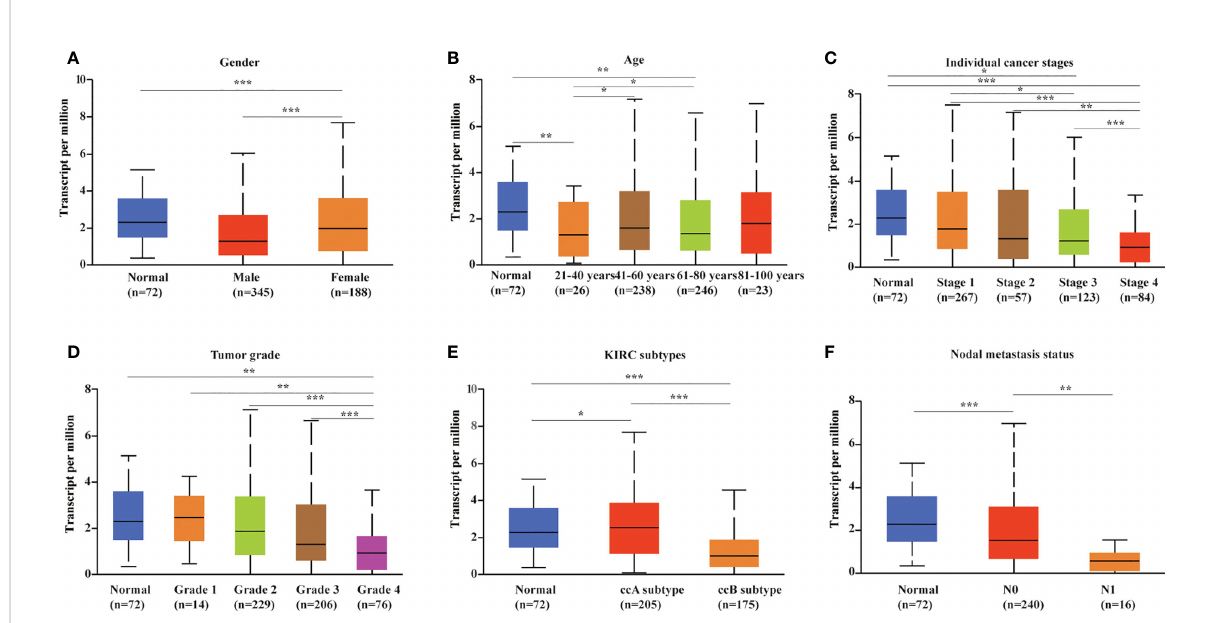
FIGURE 3 METTL24 expression in different patient groups. The box plots showed the relationship between METTL24 expression and parameters including (A) sex, (B) age, (C) cancer stage, (D) tumor grade, (E) KIRC subtype, (F) nodal metastasis status was analyzed using the UALCAN database. The T-test was used to estimate the statistical signi fi cance of expression differences between distinct groups. ***p < 0.001,**p < 0.01 and *p <